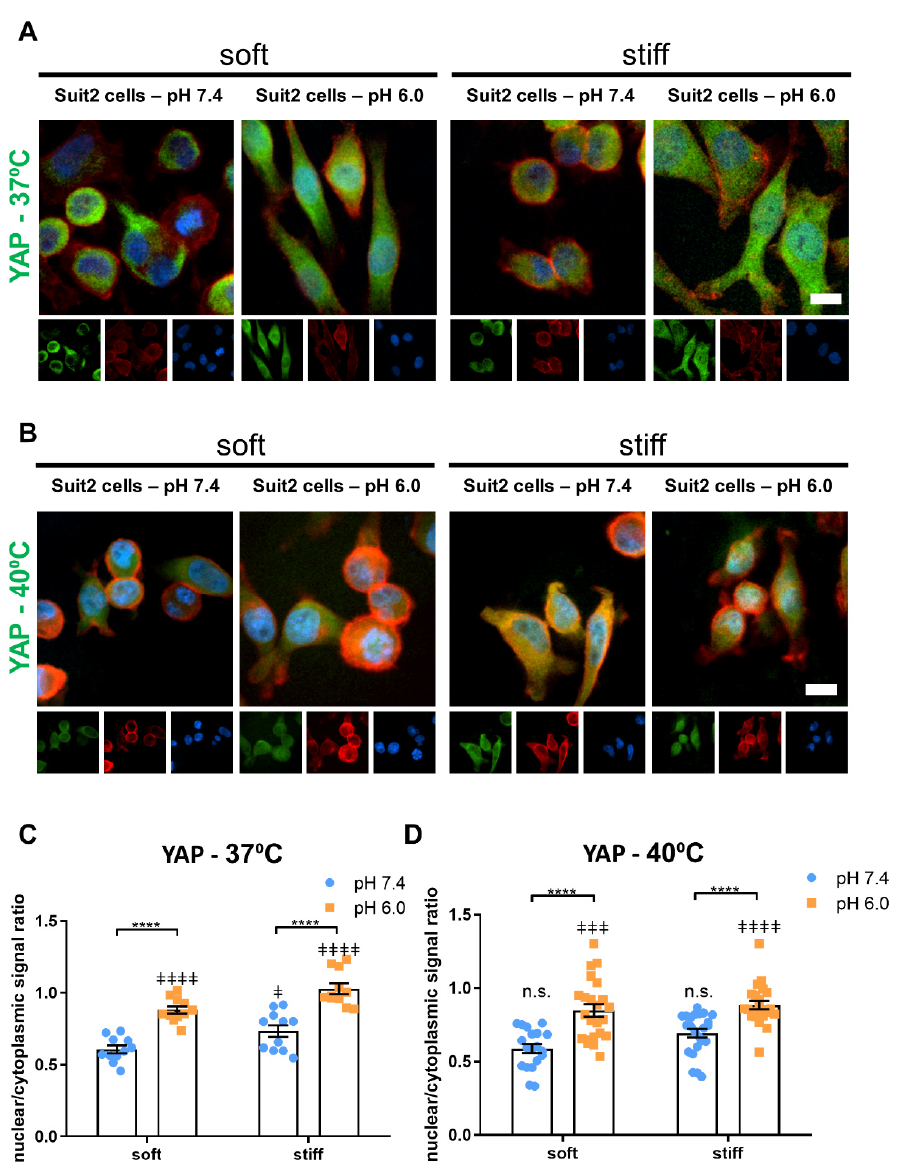
Figure 5. Acidic pH (6.0) of culture media and tumor-mimicking stiffness of the substrate increase nuclear translocation of YAP in Suit-2 007 cells. (A-B) Widefield, epifluorescent images of YAP (Yes-associated protein) for cells cultured on soft (Gamma 2) and stiff (Alpha 2) Manchester BIOGEL PeptiGels in physiologically healthy (7.4) and tumor-mimicking (6.0) pH at 37 °C ( A ) and 40°C ( B ). Protein of interest (green), actin (red) and nucleus (blue). Scale bar represents 50 µm. ( C , D ) Nuclear/cytoplasmic signal ratio assessed by measuring the MFI-mean fluorescence intensity (expressed in arbitrary units) of YAP-stained cells presented in ( A , B ), respectively. Histogram bars represent the mean ± SEM, and dots represent the average yap nuclear/cytoplasm ratio within a sample (20 cells measured per sample) across three experimental replicates. * markers denote a significant difference between bracket-marked groups by t -test, **** p < 0.0001. ‡ markers denote a significant difference from soft pH 7.4 condition at 37 °C by ANOVA with Dunnett’s post hoc test; ‡ 0.01 < p < 0.05, ‡‡‡ 0.0001 < p < 0.001 and ‡‡‡‡ p < 0.0001.